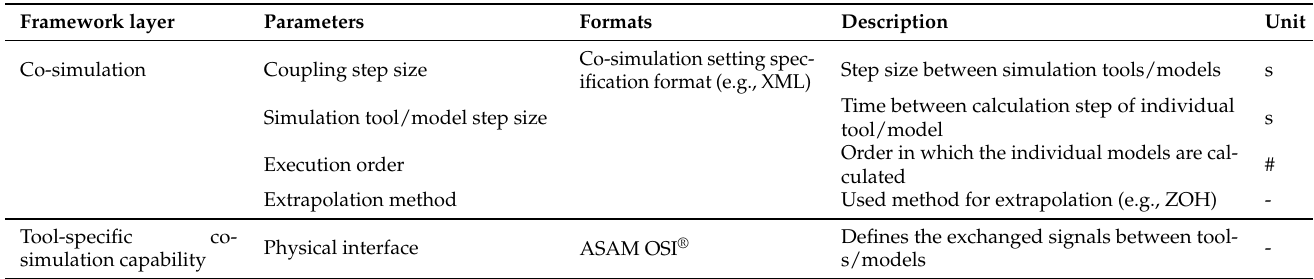
Table 7. Different framework layers and their respective parameters and